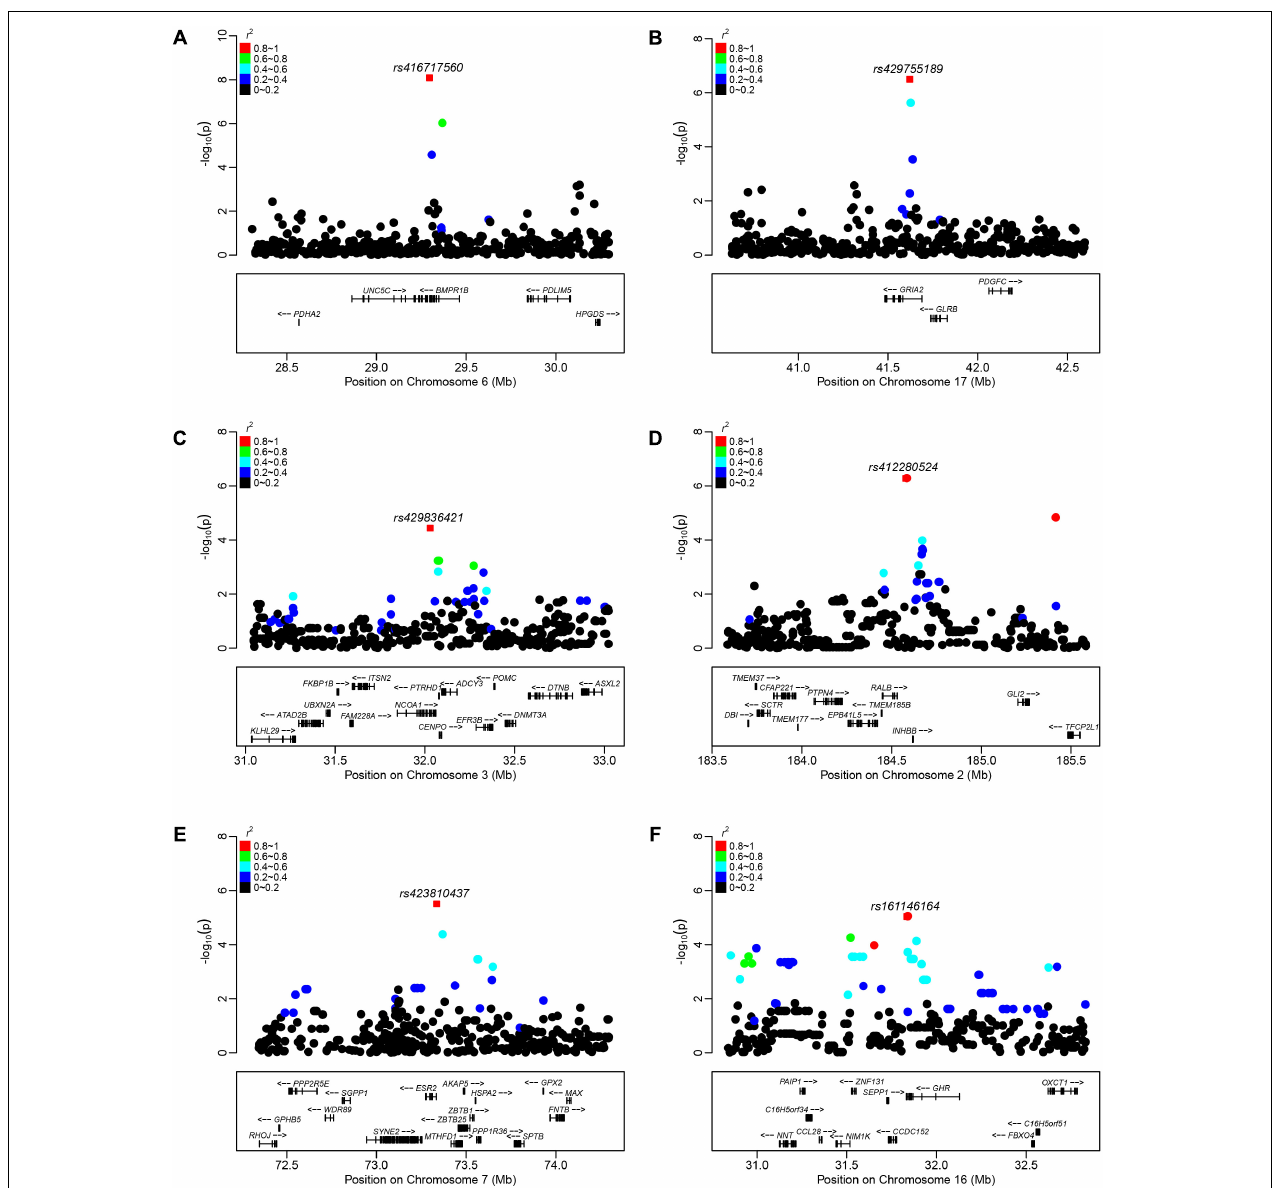
FIGURE 4 | Plots of regional association results for the top significant SNP (red square) and their near SNPs in (A) Wadi, (B) Hu, (C) Icelandic, (D) Finnsheep, (E) Romanov, and (F) Texel sheep. Different colors represent the r 2 values of pair-wise LD estimates.